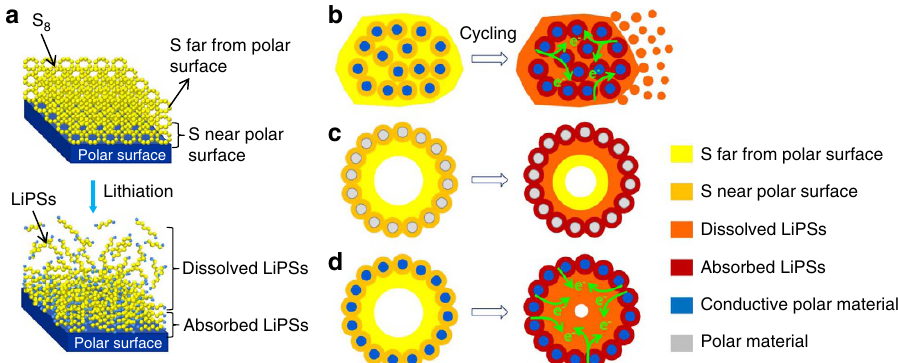
Figure 1 | Schematic illustration of the adsorption limitation of LiPSs for polar hosts. ( a ) LiPSs can be chemically adsorbed only when they are close enough to the polar surface, LiPSs far from the polar surface cannot be effectively anchored during the cycling. ( b ) Conductive polar nanoparticles can chemically adsorb LiPSs near their surfaces. When the sulfur content of the composite exceeds the limit, the extra LiPSs would dissolve into the organic electrolyte. ( c ) The hollow polar structure can bond with LiPSs near the surface, and effectively restrict the diffusion of the inner LiPSs. However, the low conductivity of the host hinders high sulfur utilization. ( d ) The conductive polar hollow structure inherits both advantages of b , c